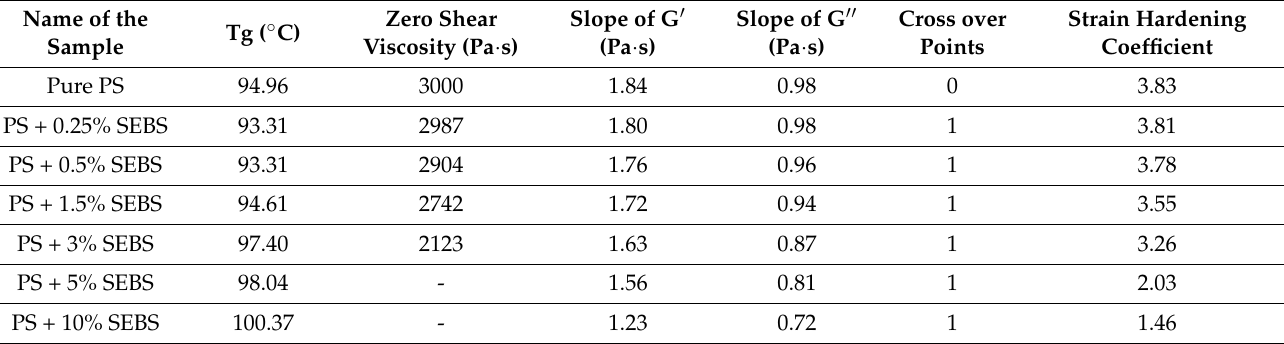
Figure 2. Results obtained after characterizing the rheological behavior of the different materials. ( a ) Shear dynamic rheology results. ( b ) Extensional rheology results. Table 1. Glass transition temperature and shear and extensional rheology properties of the formulations